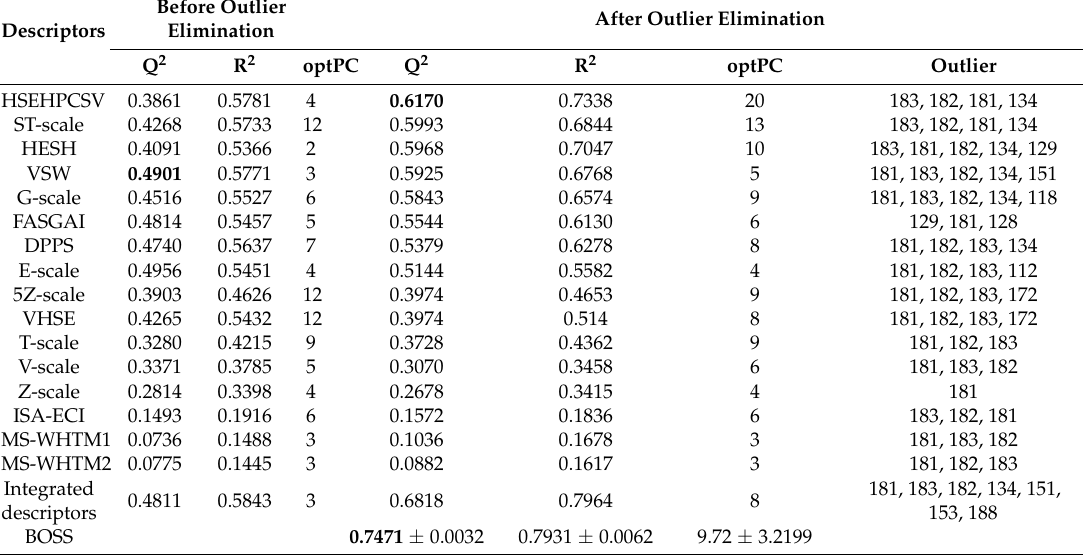
Table 1. Comparisons among different quantitative structure-activity relationships (QSAR) models on ferric thiocyanate (FTC) dataset a .